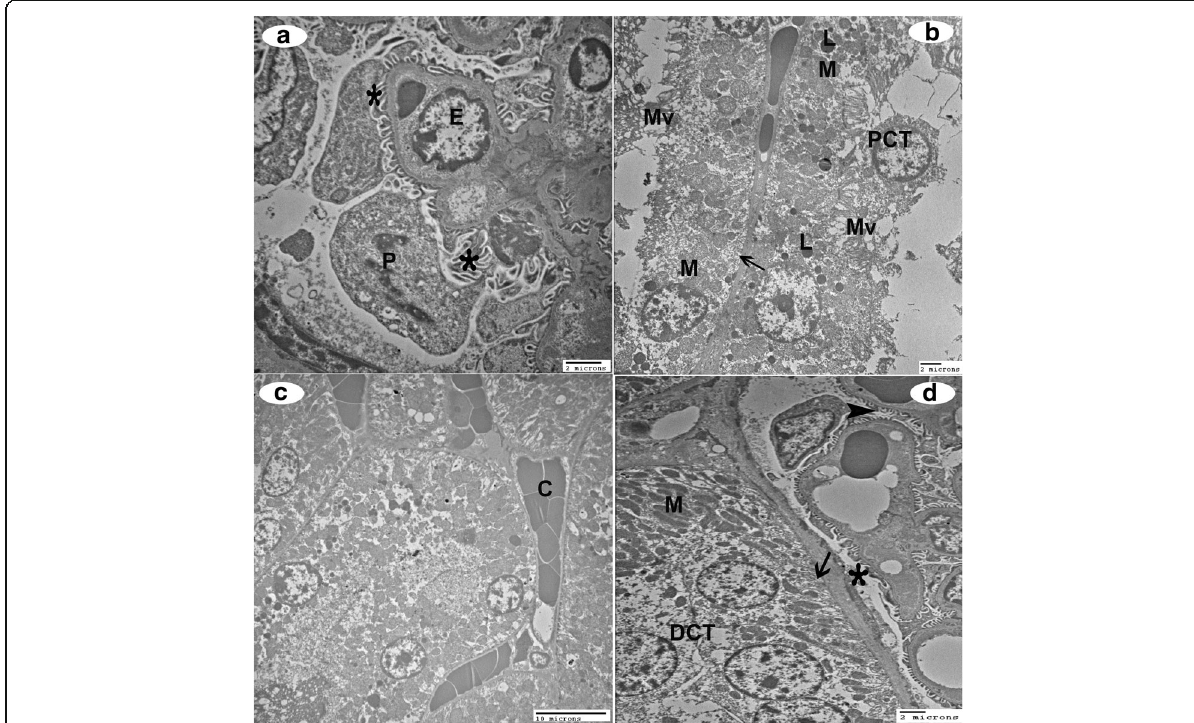
Fig. 3 Electron micrographs of the rat cortex of KT group. a Glomerular vacuolation in the nuclei and cytoplasm of endothelial cell (E) and podocyte (P), note the hypertrophic processes of podocytes (asterisk). b PCT with severe vacuolation, fragmented microvilli (Mv), damaged mitochondria (M), fragmented basal enfolding (arrow), and many lysosomes (L). c Congested blood capillaries (C) in between the vacuolated kidney tubules. d Severe vacuolation in the DCT, disorganized mitochondria (M), and fragmented basal enfolding (arrow), note the narrow Bowman ’ s space (asterisk) and hypertrophic processes of podocytes (arrow head) (scale bar = 2 μ